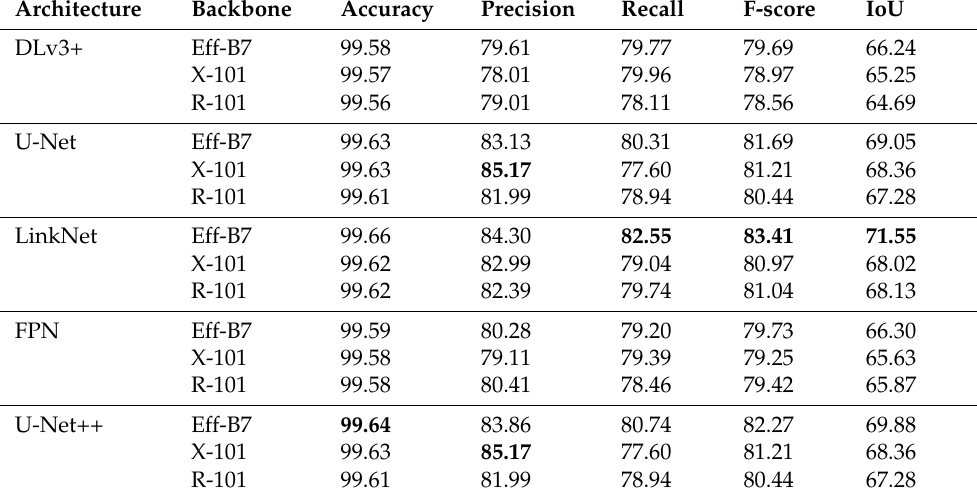
Table 3. Accuracy, precision, recall, F-score, and intersection over union (IoU) metrics for